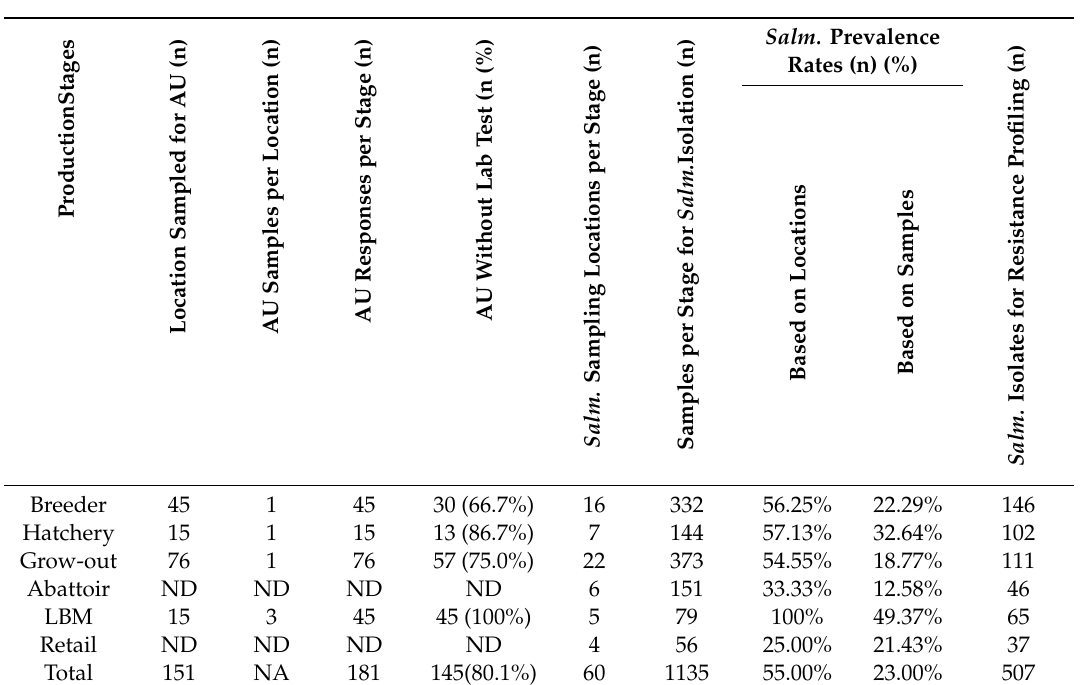
Table 1. Demography of antimicrobial resistance profiling of Salmonella spp. at the production stages along the broiler value chain in